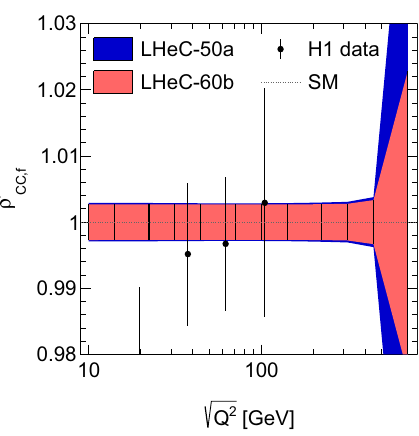
Fig. 15 Scale dependent determination of the anomalous CC coupling parameters, assuming ρ (cid:9) ues from H1 [18] are also